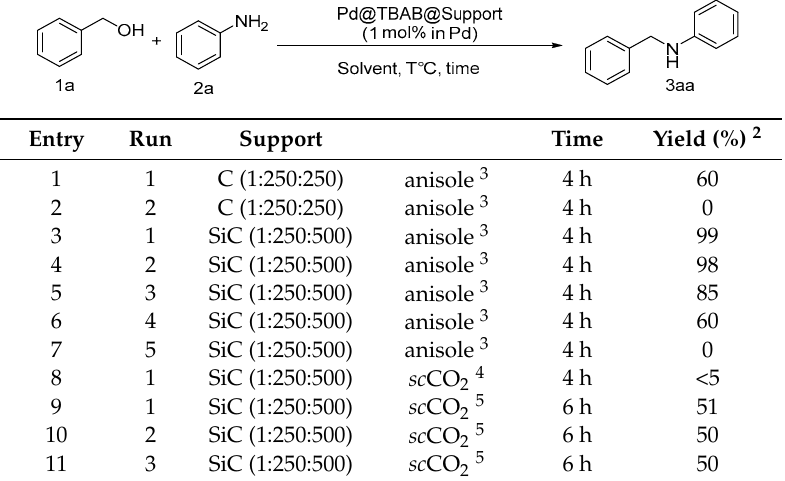
Table 4. Recycling of heterogeneous catalyst 1 .